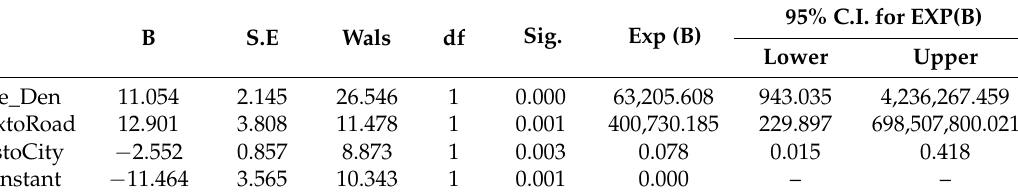
Table 7. Variables in the equation.